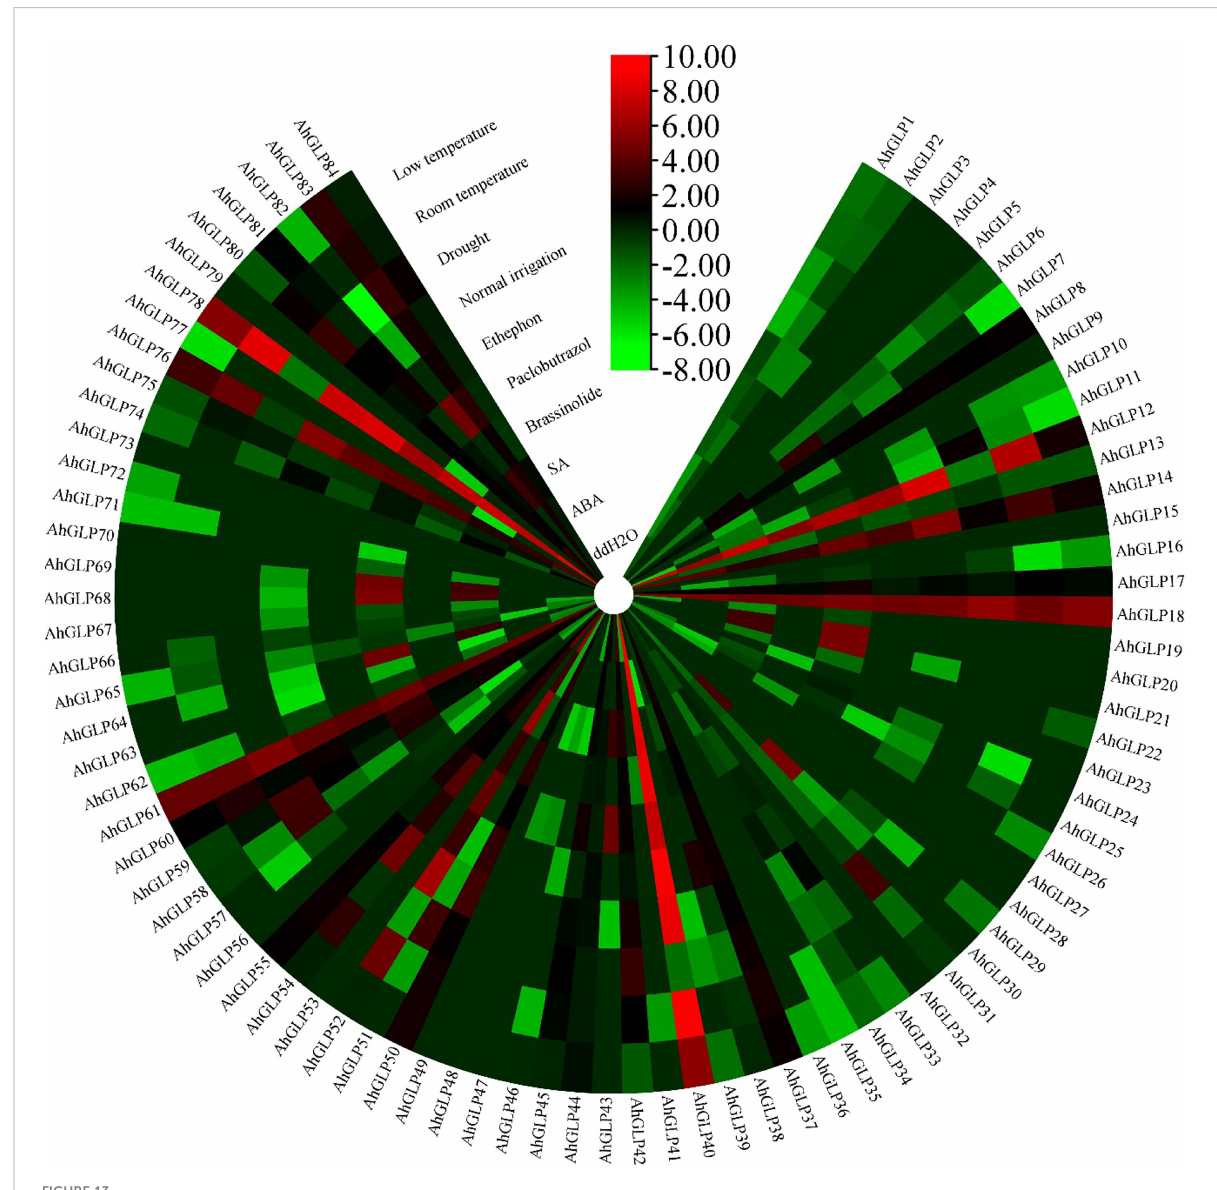
FIGURE 13 Transcriptome expression of AhGLPs under different hormones and stress conditions. Most of AhGLPs are not responsive to different stress treatments, while few genes AhGLP12 , AhGLP18 , AhGLP40 , AhGLP61 , and AhGLP78 showed good responses to all stress/normal